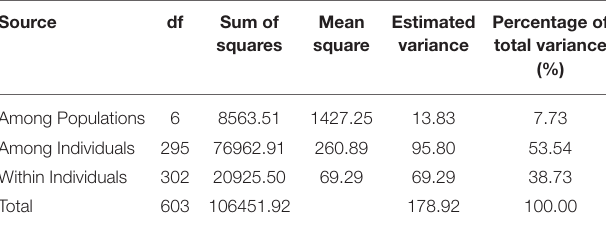
Source df Sum of